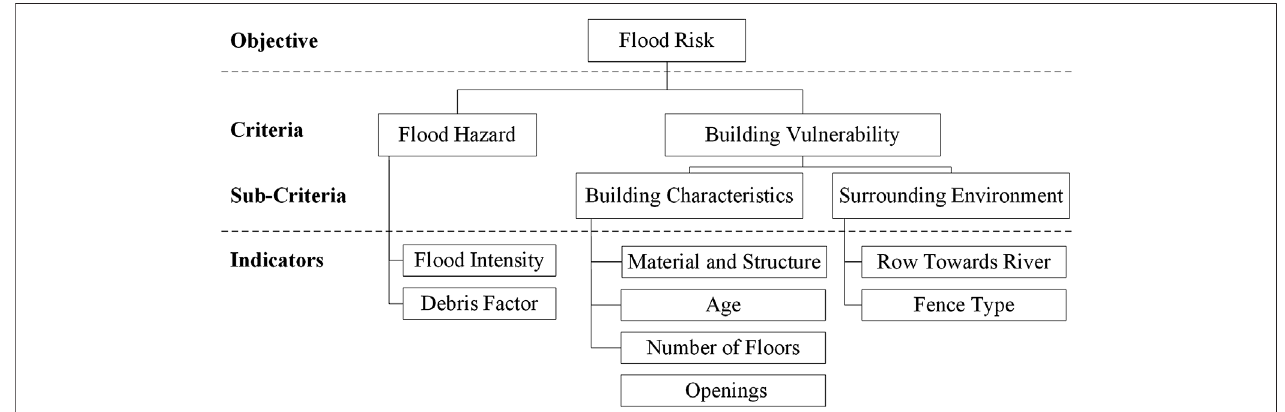
FIGURE 6 | Hierarchical structure of building fl ood risk